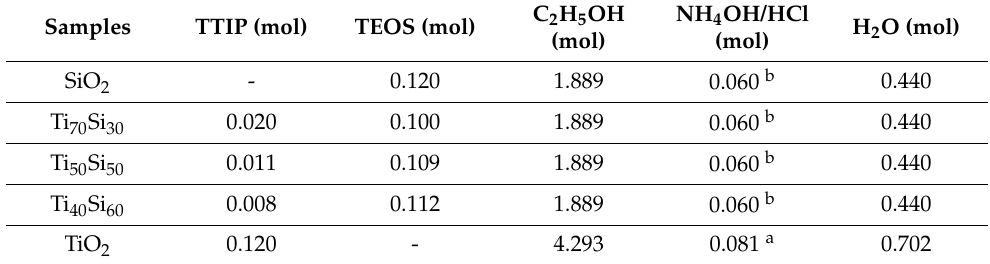
Table 2. Moles of components in Ti x Si y oxide synthesized at pH 9.0 with different Ti/Si ratios.